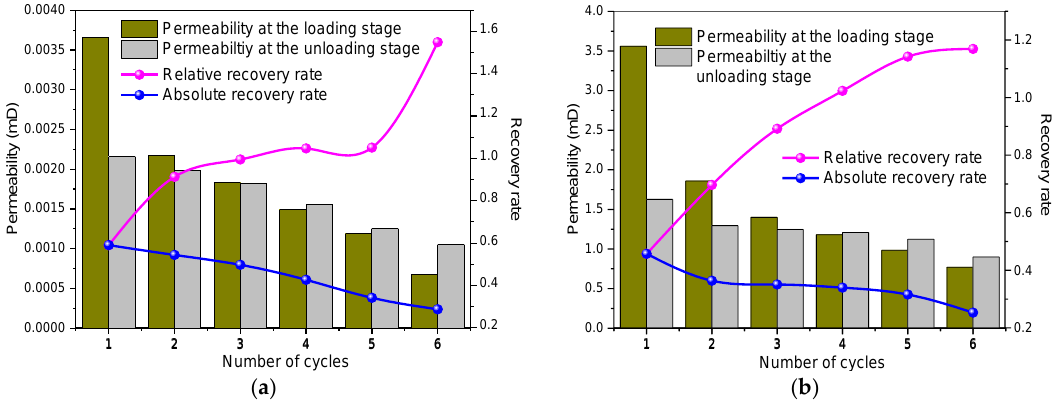
Figure 14. Changes in the absolute and relative recovery rates of the permeability of raw coal under cyclic loading–unloading paths 2 and 3. ( a ) Stress path 2. ( b ) Stress path 3.